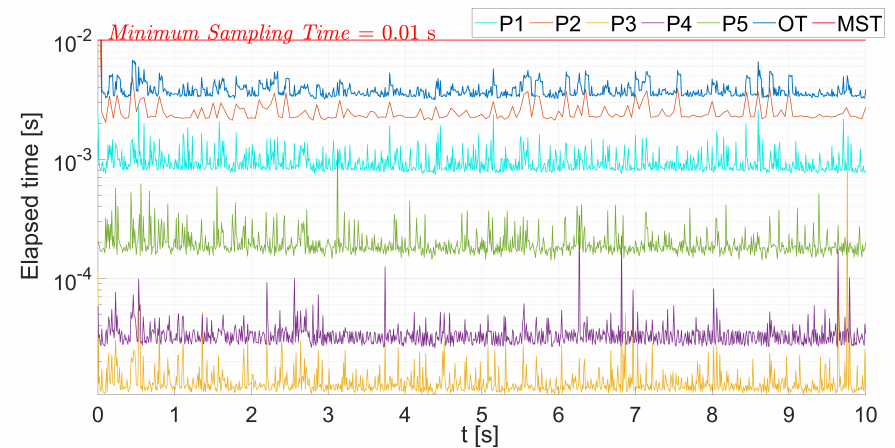
Figure 11. Elapsed time for each phase of the proposed filter, compared to the minimum sampling time (MST). In particular, we have: P1 = prediction phase, P2 = 3D/2D map conversion phase, P3 = row selection phase, P4 = distance filter phase, P5 = update phase, OT = overall